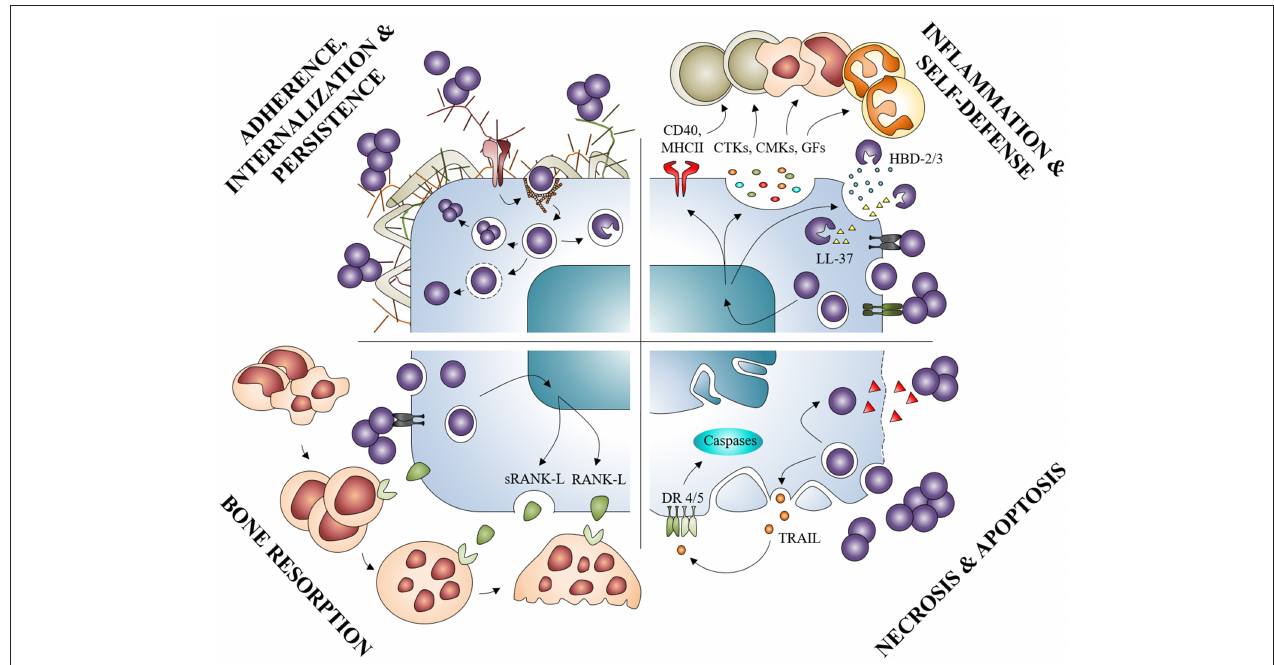
FIGURE 6 | Summary diagram of the osteoblasts responses in presence of Staphylococcus aureus . S. aureus can interact with osteoblasts and provoke: inflammation by increased release of mediators such as cytokines (CTKs), chemokines (CMKs), or growth factors (GFs); osteoblast self-defense by the production of AMPs (HBD-2/3, LL-37); osteoblasts death through apoptosis or necrosis; bone resorption by activation of the RANK/RANK-L